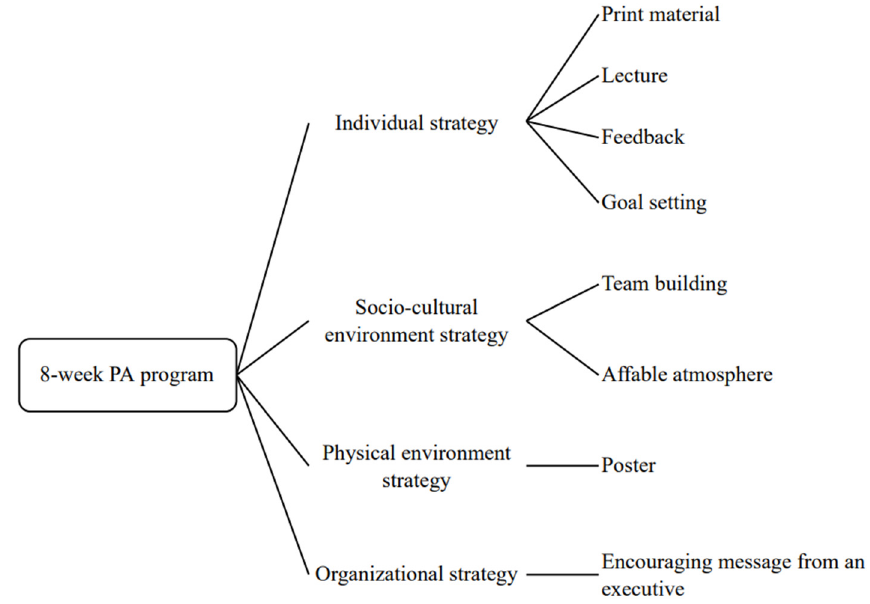
Figure 1. Comprehensive and multi-component PA